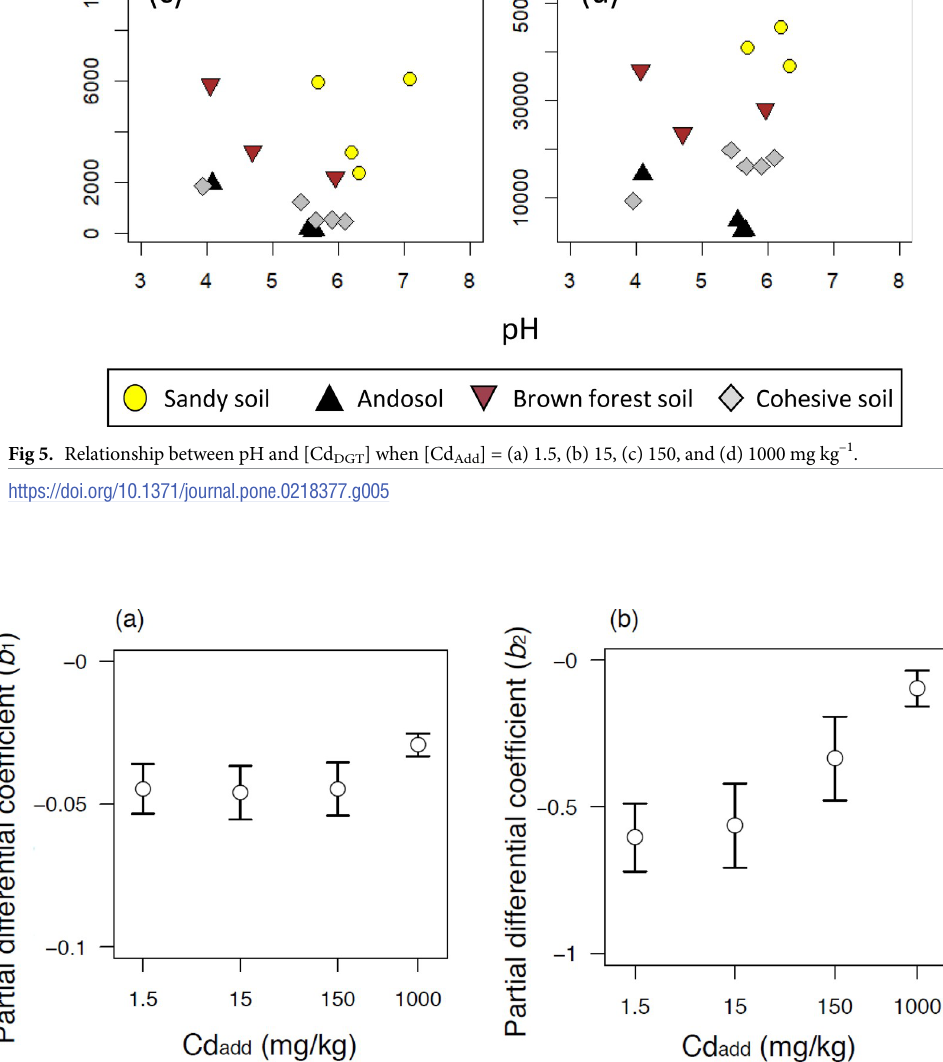
PLOS ONE | https://doi.org/10.1371/journal.pone.0218377 June 14,